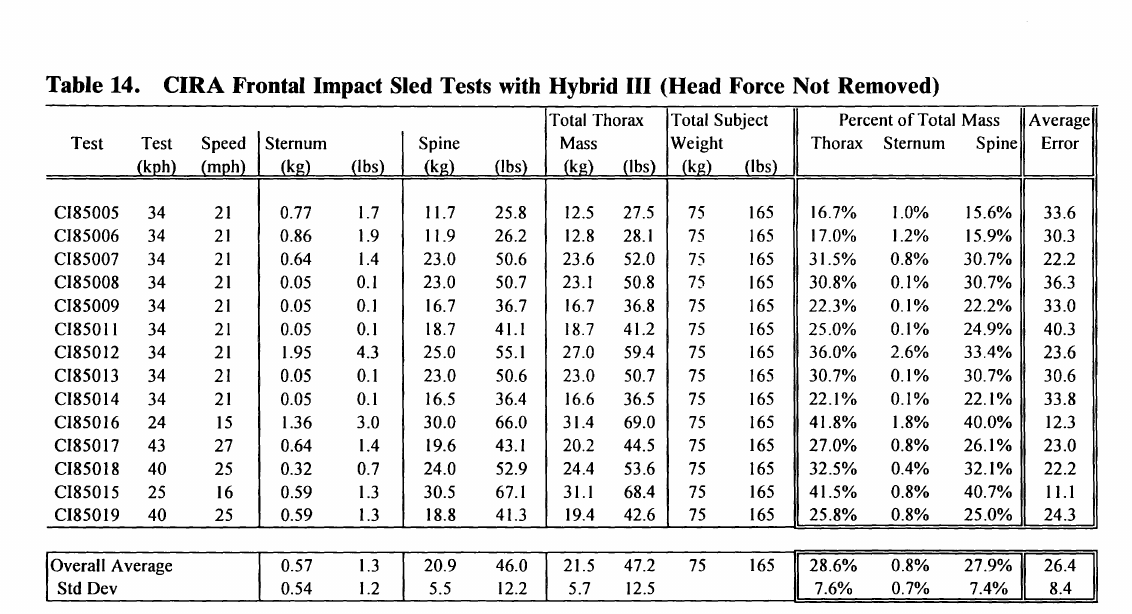
Table 14. CIRA Frontal Impact Sled Tests with Hybrid III (Head Force Not Removed)